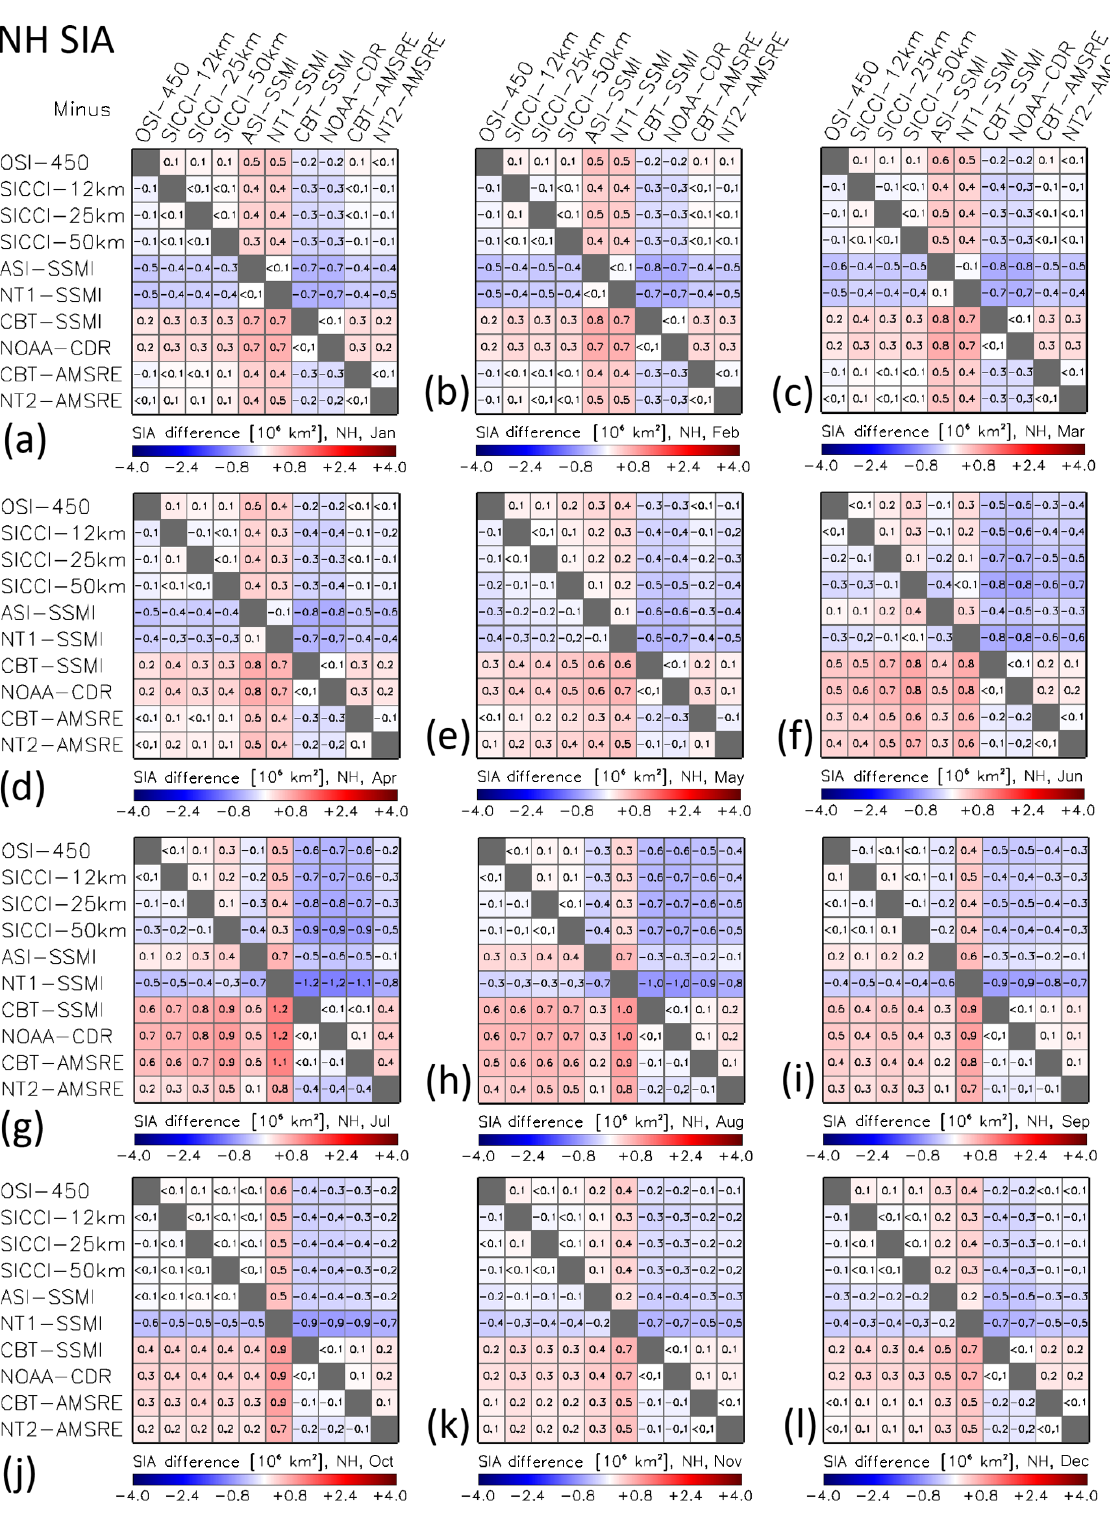
Figure G2. Differences between all 10 products of the average sea-ice area (SIA) for the Arctic. The differences are computed from monthly mean SIA of the respective months of the AMSR-E period June 2002 to September 2011. All data are on the EASE-Grid 2.0 with 50km grid resolution. The land mask of the SICCI-50km product is applied to all